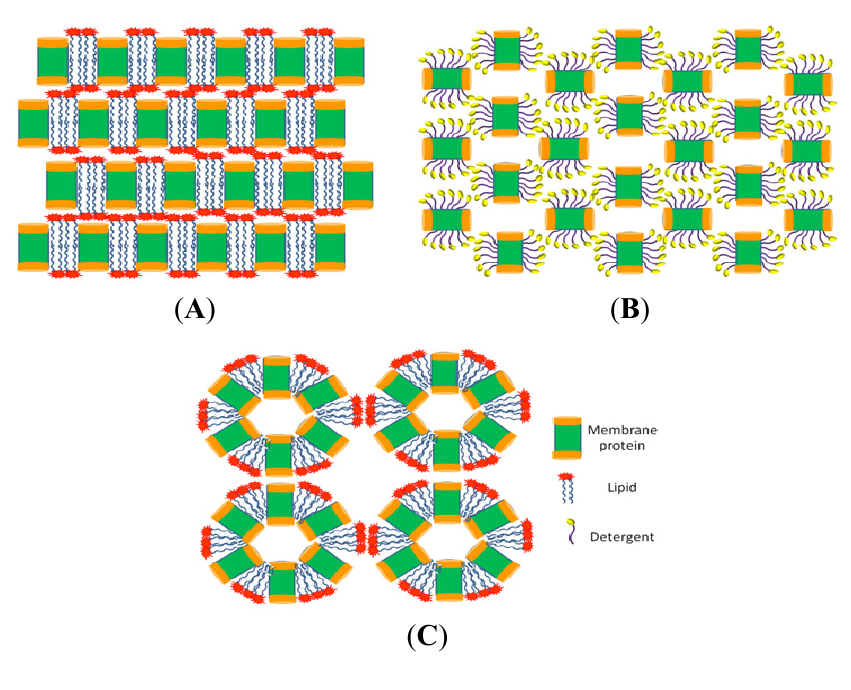
Figure 12. Different crystal types of membrane proteins. ( A ) Type I crystals: layers of membrane proteins stacked side by side, with hydrophobic surfaces providing crystals contacts, are stacked one on another; ( B ) Type II crystals: detergent molecules shield hydrophobic regions of membrane proteins and crystal contacts involve only polar heads; ( C ) Type III crystals: vesicular proteoliposomes forming the crystalline